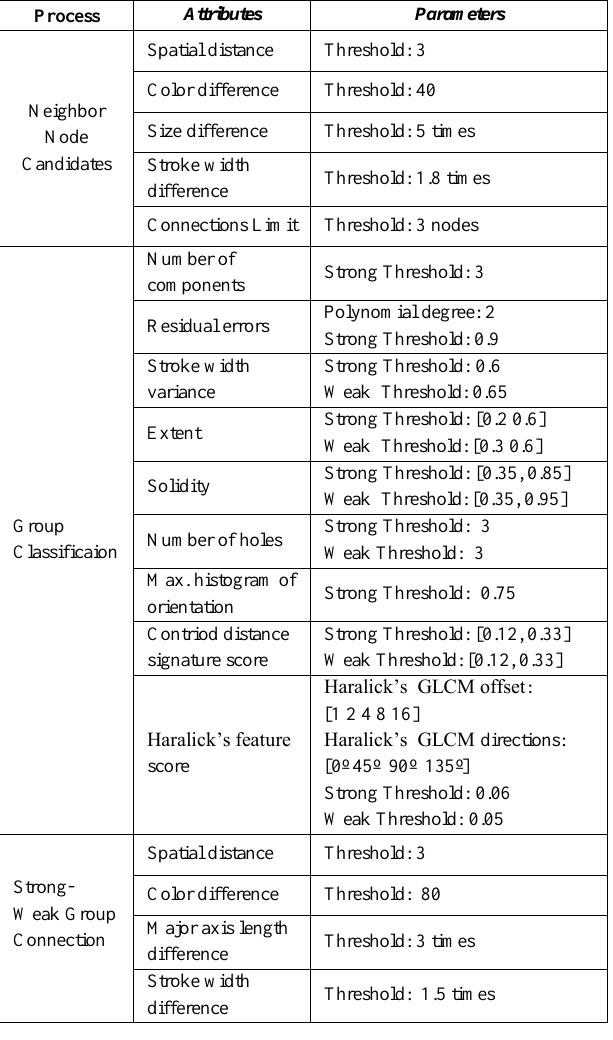
TABLE I. P ARAMETERS AND T HRESHOLDS USED IN THE E XPERIMENT Process